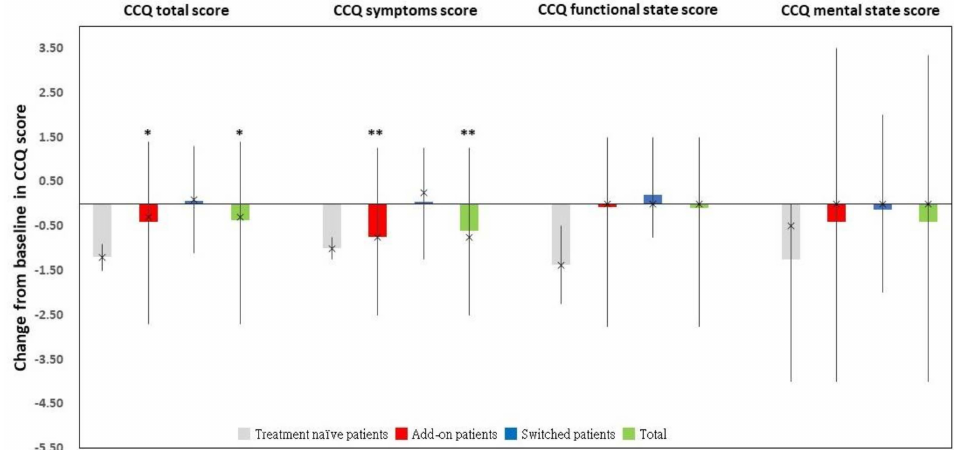
Figure 3. The change from baseline in CCQ total and domain scores in the “Completers” dataset and its corresponding subgroups. * p < 0.05. ** p < 0.001. Abbreviations: CCQ, clinical COPD